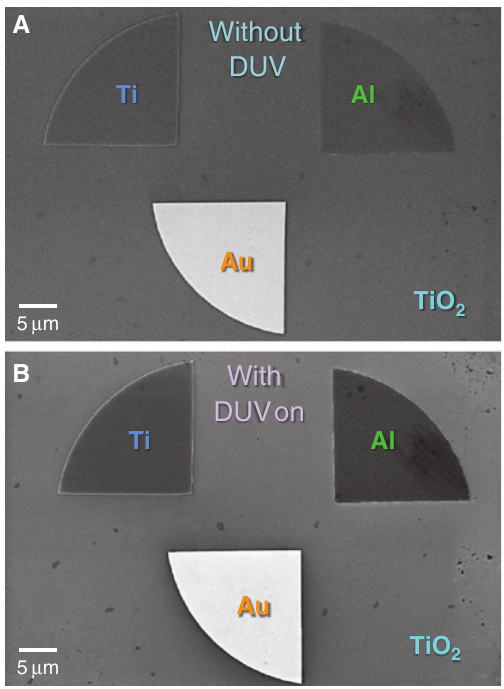
Figure 13: SEM images of titanium, aluminium and gold structures taken without (A) and with (B) deep-UV illumination [8]. The work functions are: 5.1−5.47 eV for Au, 4.33 eV for Ti, 4.06−4.26 eV for Ti, ~ 4.68 eV for PMMA resist residue; the used photon energy was 4.8 eV ( ~ 260 nm